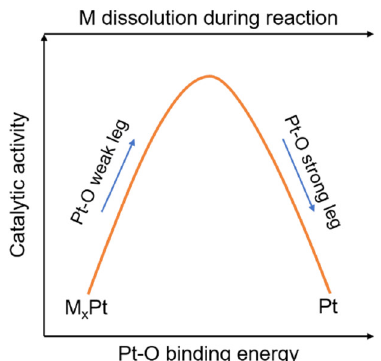
Figure 1. Illustration of catalytic activity of MPt catalysts as Sabatier volcano-type function of Pt − O binding energy [35]. An optimal design of Pt-based catalysts should let Pt–O binding energy place at the weak leg near the apex in order to balance the competition between activity and durability.